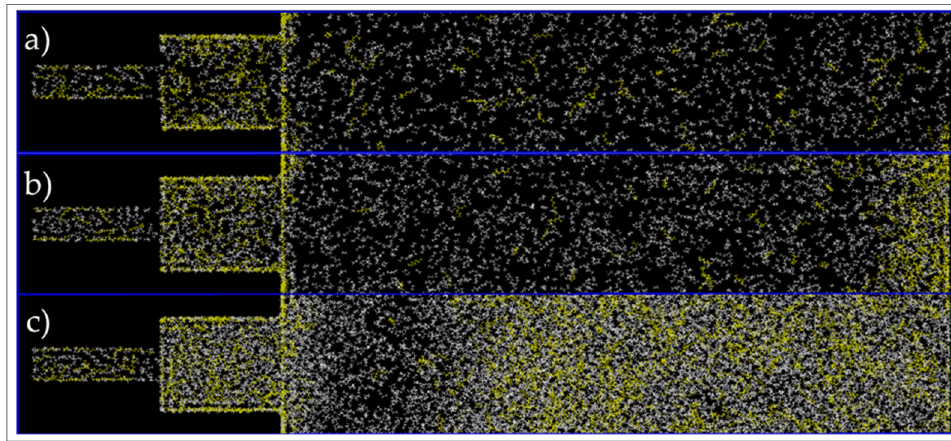
Figure 21. End of simulation images of the connected pores and bulk, at C1 ( a ), C2 ( b ), and C3 ( c ) conditions. Yellow and white colors represent heptane and ethane molecules, respectively.